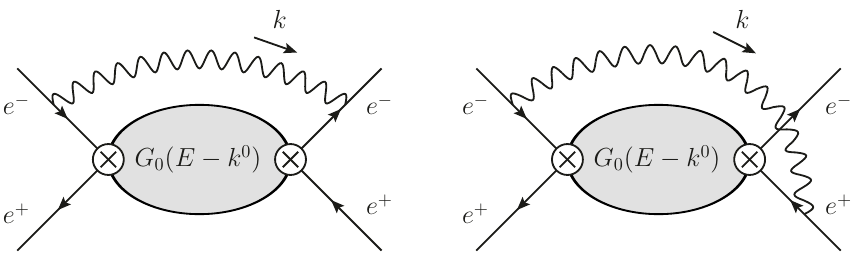
Figure 8 . Ultrasoft photon corrections to the resonant cross section. The symmetric diagrams, obtained by the interchange of electrons and positrons, are not